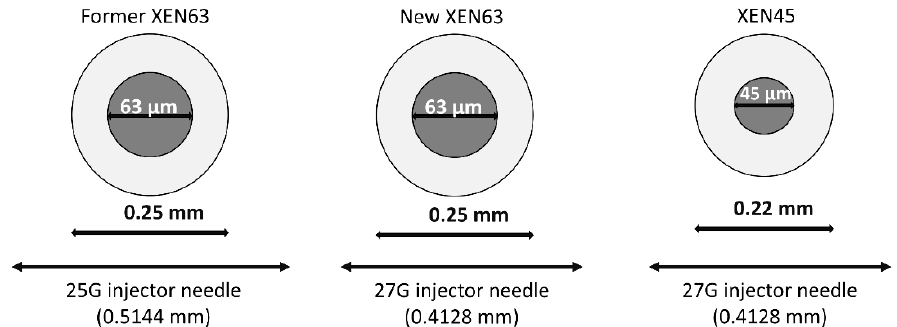
Figure 1. A comparison of the outer and inner diameters of the former XEN63, new XEN63, and XEN45 devices. The former XEN63 device was inserted by using a 25G needle injector (with an outer diameter of 0.5144 mm), while the new XEN63 device is inserted by using a 27G needle injector (with an outer diameter of 0.4128 mm, which is 19.8% smaller). As compared to XEN45 implant, the outer diameter of XEN63 is only 12% greater, while the inner diameter is 1.4 times greater. Since the new XEN63 and the XEN45 devices are inserted by using a 27G injector needle, the side flow with the XEN63 is reduced compared with the XEN45.